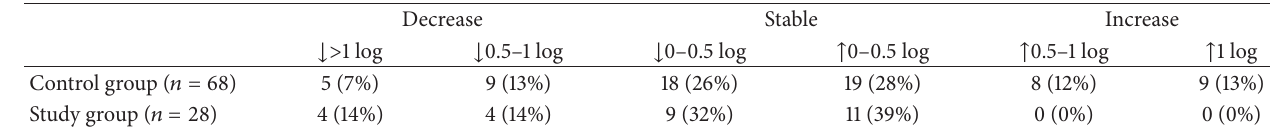
Table 3: The effects of CIT on levels of virus load in HCC.